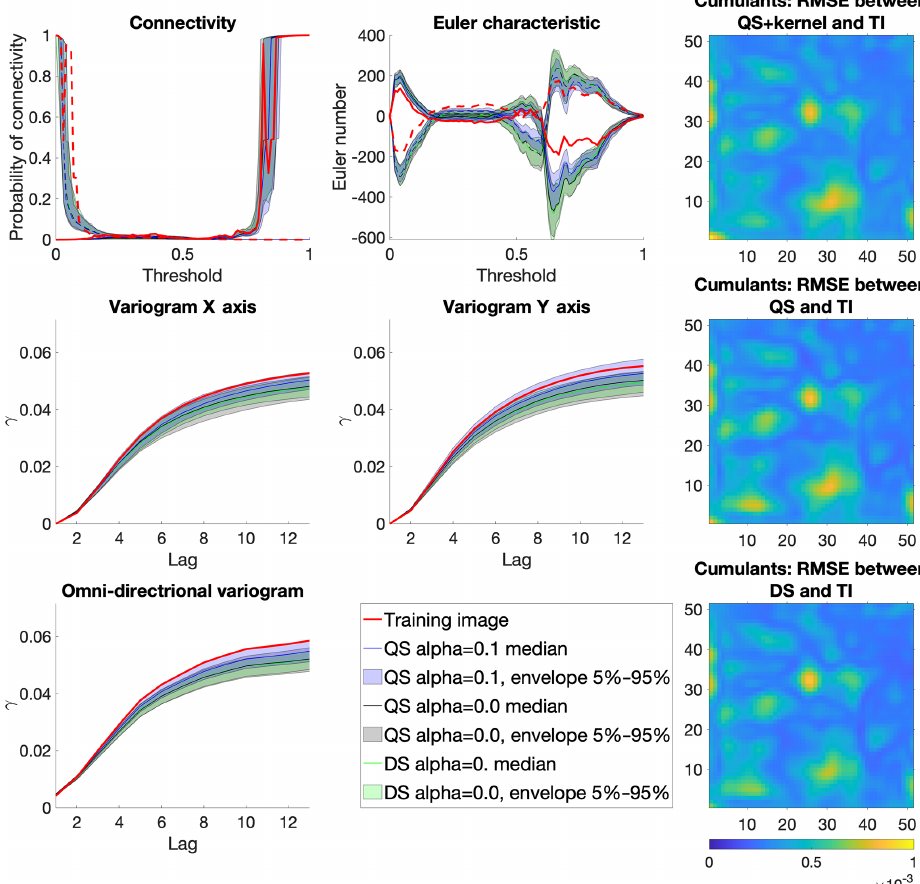
Figure 6. Benchmark between QS (with and without kernel) and DS over six metrics using each time 100 unconditional